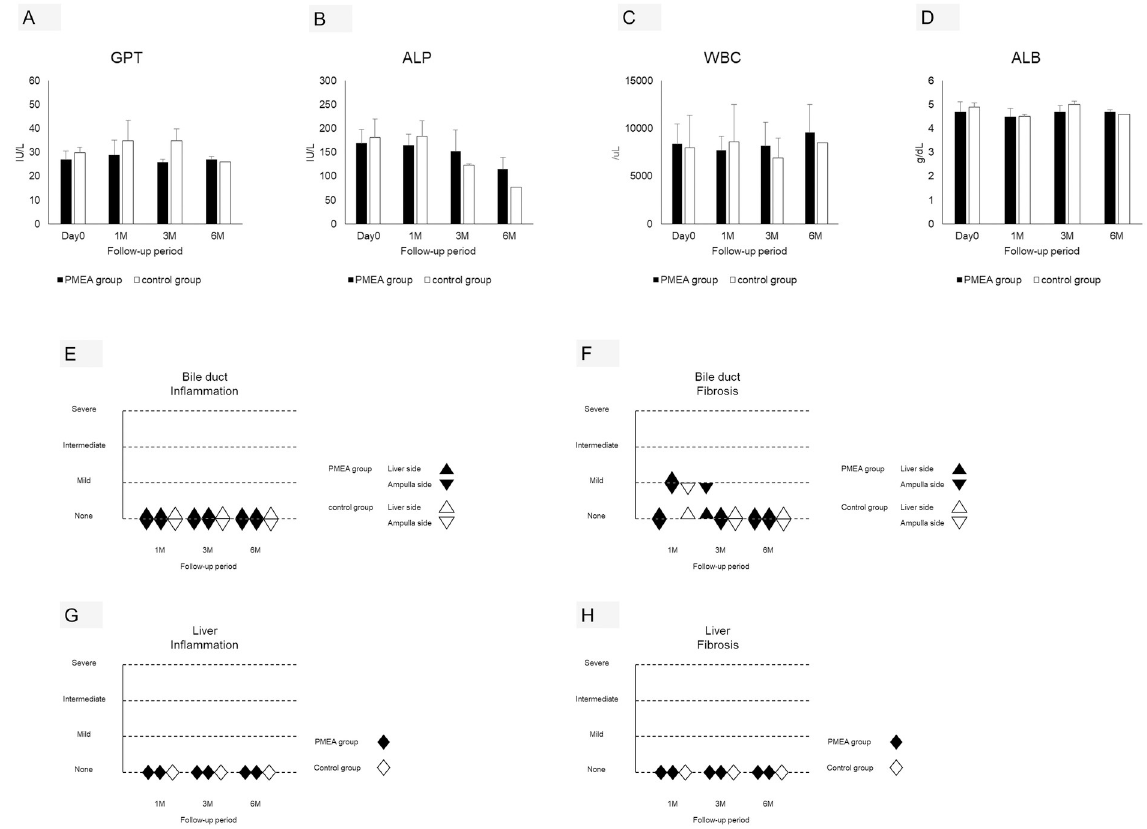
Fig 2. Blood biochemical and pathological evaluations of the PMEA and conventional CSEMS groups. A–D: No increase in GPT, ALP, and ALB levels or in the WBC count was observed in either of the groups at any of the follow-up time points. E–H: Nearly no pathological changes were observed in either of the groups at follow-up. GPT, glutamic pyruvic transaminase; ALP, alkaline phosphatase; WBC, white blood cell; ALB, albumin. https://doi.org/10.1371/journal.pone.0257828.g002 conventional CSEMS groups, the USEMS group showed severe inflammatory cell infiltration and mild fibrosis at 20 days (Fig 3G and 3H). Compared with the PMEA-CSEMS and conven- tional CSEMS groups, the control group without ERCP showed no inflammatory cell infiltra- tion and fibrosis (Fig 3J). In the pathological evaluation of the liver, no inflammatory cell infiltration or fibrosis was observed at any of the time points in the PMEA-CSEMS and con- ventional CSEMS groups (Figs 2G, 2H, 3C and 3F). Compared with the PMEA-CSEMS and Table 1. Statistical analysis of the blood biochemical evaluation results of the PMEA-CSEMS and conventional CSEMS groups.